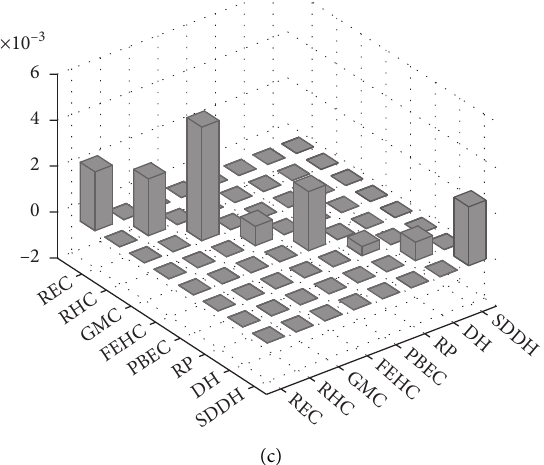
Figure 5: The relative covariance matrix generated by CUSA with the sample size of 200. (a) Generated by SRS. (b) Generated by LHS. (c) Generated by LHS-SVDC.